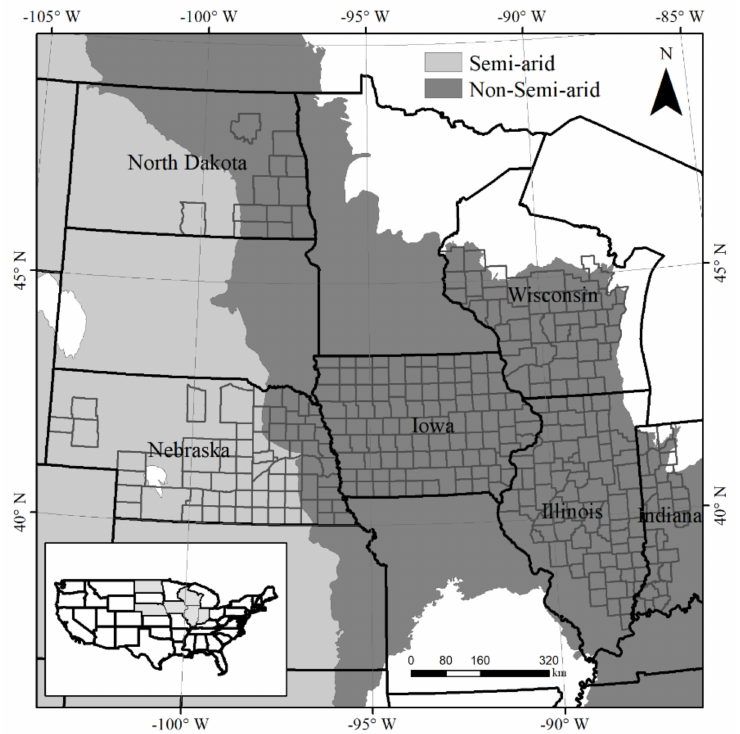
Figure 1. Spatial distribution of selected counties, which are divided into semi-arid and non-semi- arid